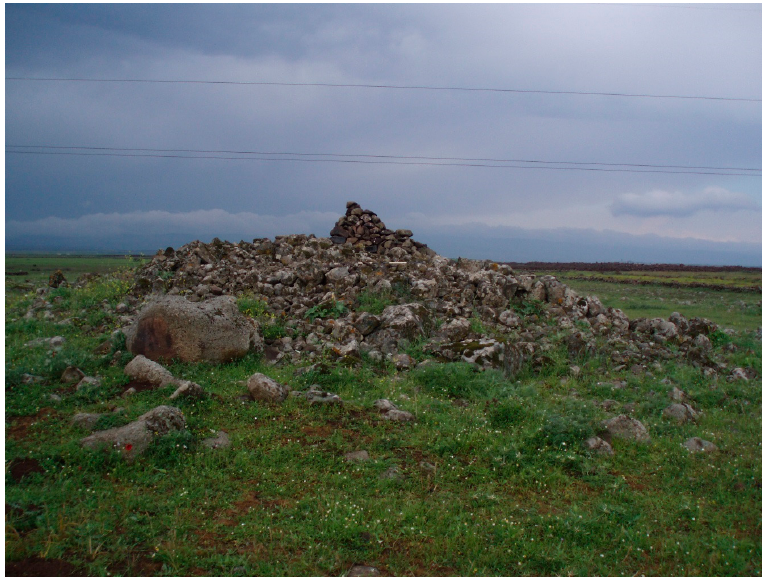
Figure 11. Image of cairn surveyed in the field in spring 2007. The cairn has a modern shelter constructed on top of it, and areas of structural collapse are visible in the image. Geosciences 2017 , 7 , 100